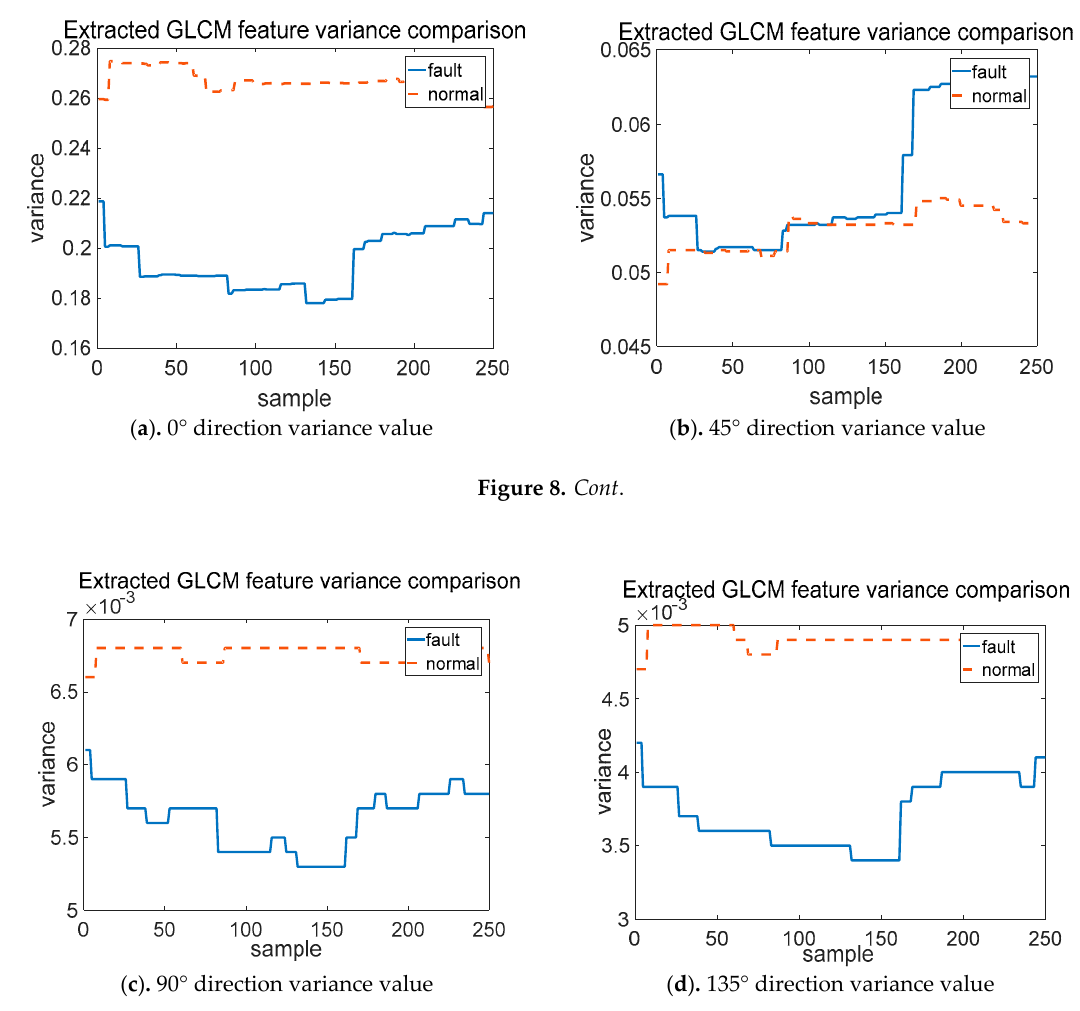
Figure 7. GLCM feature average comparison chart.